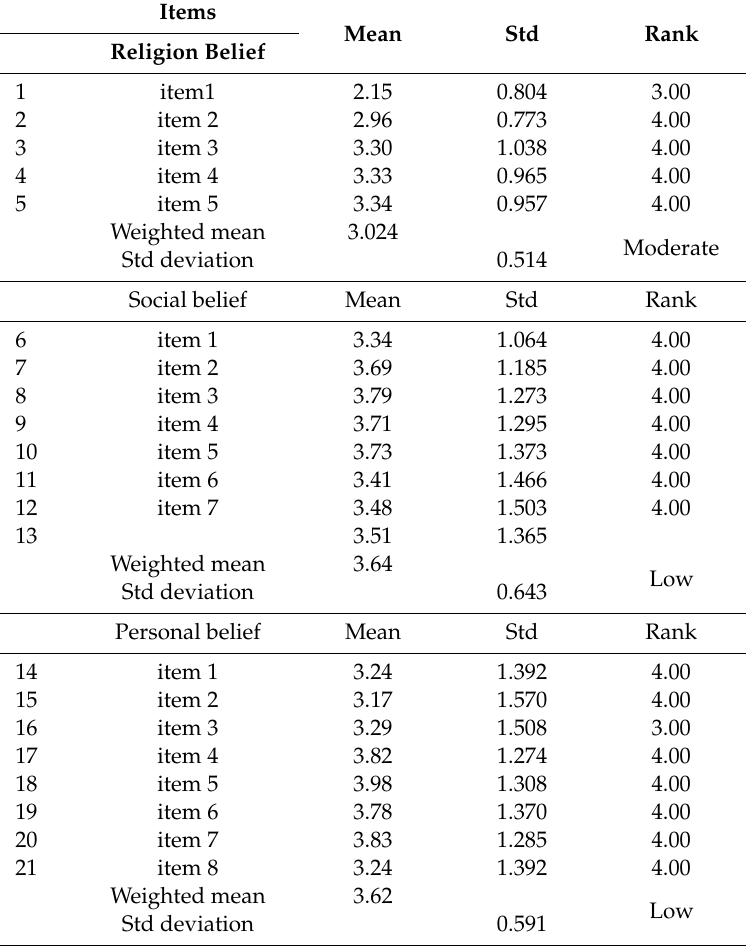
Table 2. Preschool teachers’ beliefs regarding autism spectrum disorder. Items Mean